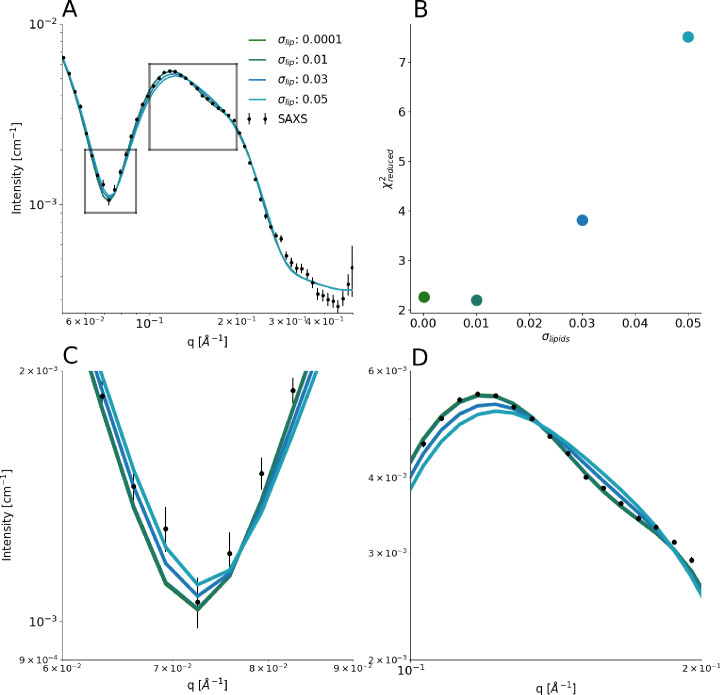
Introducing polydispersity in the model.We implemented a model for the nanodiscs that included a normally distributed dispersity around the average number of embedded lipids, where the width of the Gaussian was defined by its relative standard deviation in the number of embedded lipids, σl⁢i⁢p, and truncated the Gaussian at ±3⁢σl⁢i⁢p. An upper hard limit for the number of lipids in the distribution was furthermore defined by the value that yielded circular and hence fully loaded discs. A lower hard limit was defined by the value that yielded discs with axis ratios exceeding 2. (A) Comparison between experimental SAXS data and those calculated from the model with different values of σl⁢i⁢p, with σl⁢i⁢p=10-4 representing a monodisperse system. (B) Quantification of the agreement between experiment and model. (C and D) show zoom ins on regions highlighted in A.